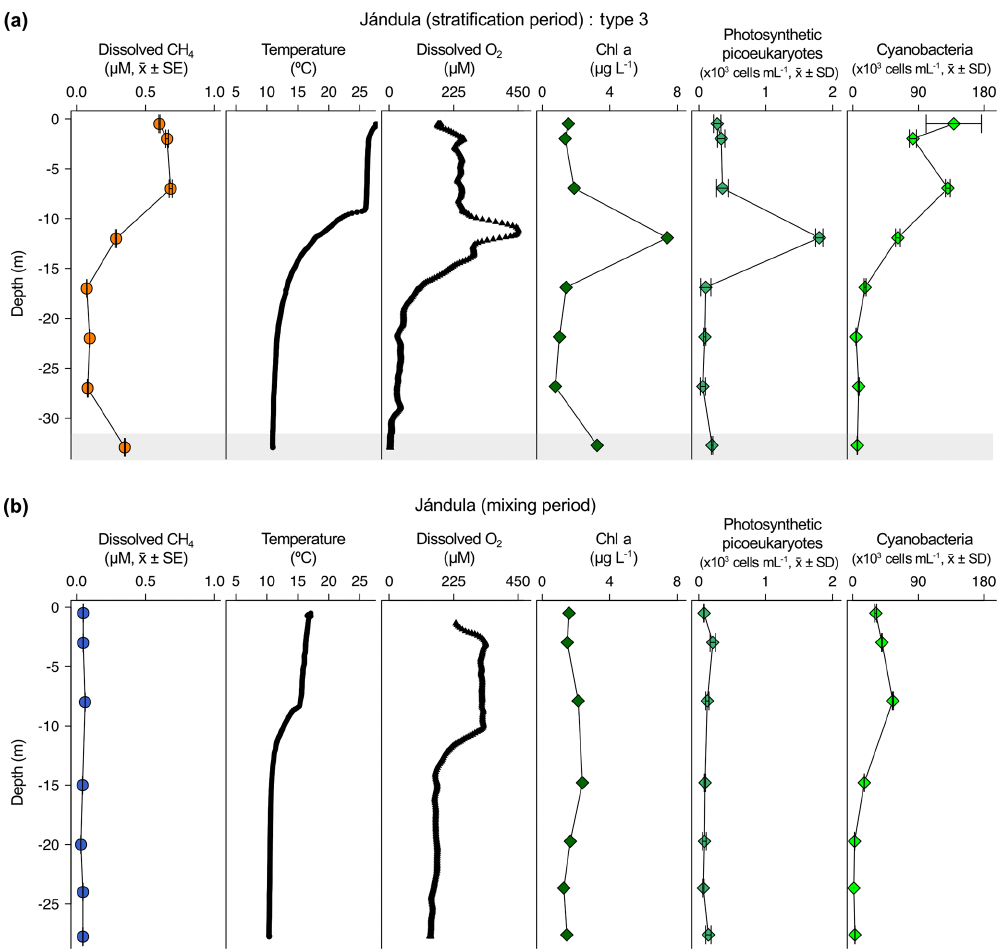
Figure 4. Vertical profiles of physicochemical and biological variables in Jándula reservoir. Dissolved methane concentration (CH 4 , µM, mean ± standard error), temperature ( ◦ C), dissolved oxygen (DO) concentration (µM), chlorophyll a (Chl a ) concentration (µgL − 1 ), abun- dance of photosynthetic picoeukaryotes ( × 10 3 cellsmL − 1 , mean ± standard deviation), and abundance of cyanobacteria ( × 10 3 cellsmL − 1 , mean ± standard deviation) during the stratification period (a) and the mixing period (b) . The grey area represents the anoxic zone (DO < 7 . 5µM). The sampling for the stratification period was on 24 July and 5 April 2017 for the mixing period.